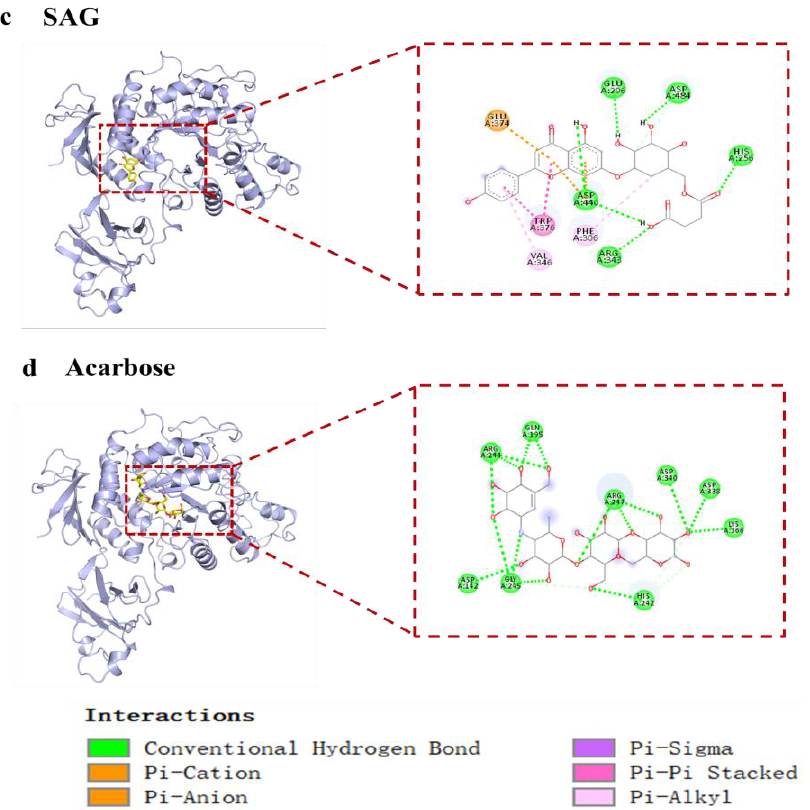
Figure 2. The interaction of active compounds with α -glucosidase (( a ) apigenin, ( b ) apigenin-7- O - β - D -glucoside (AG), ( c ) apigenin-7- O - β - (6″ - O -succinyl)- D -glucoside (SAG), ( d ) acarbose).